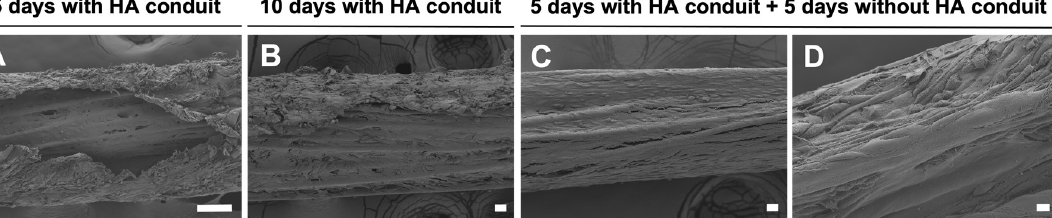
Figure 8. Schwann cells distribution in multimodular conduits and ‘neural cord’. Scanning electron microscopic image from a longitudinal cut in multimodular conduits after ( A ) 5-days culture and ( B ) 10-days culture. ( C , D ) Scanning electron microscopic image of the ‘neural cord’ after 5 days of culture outside the HA conduit. Scale bar: 100 µ m ( A ), 20 µ m ( B , C ), 10 µ m ( D